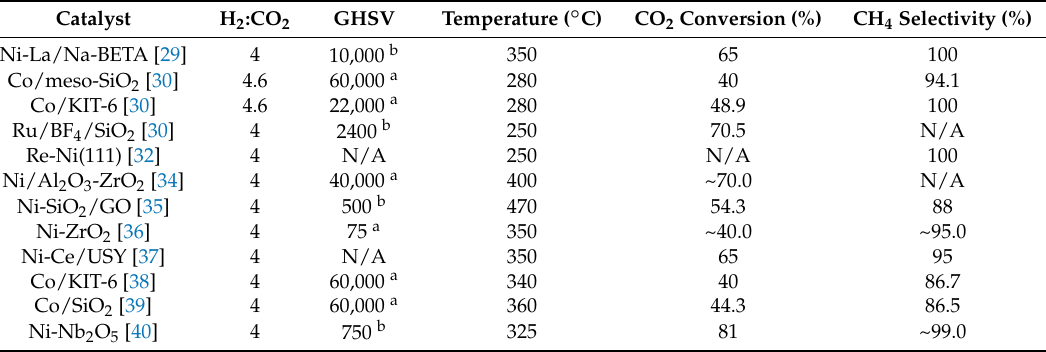
Table 2. Catalytic performance of several catalysts for CO 2 methanation, in terms of CO 2 conversion and CH 4 selectivity, along with the reaction